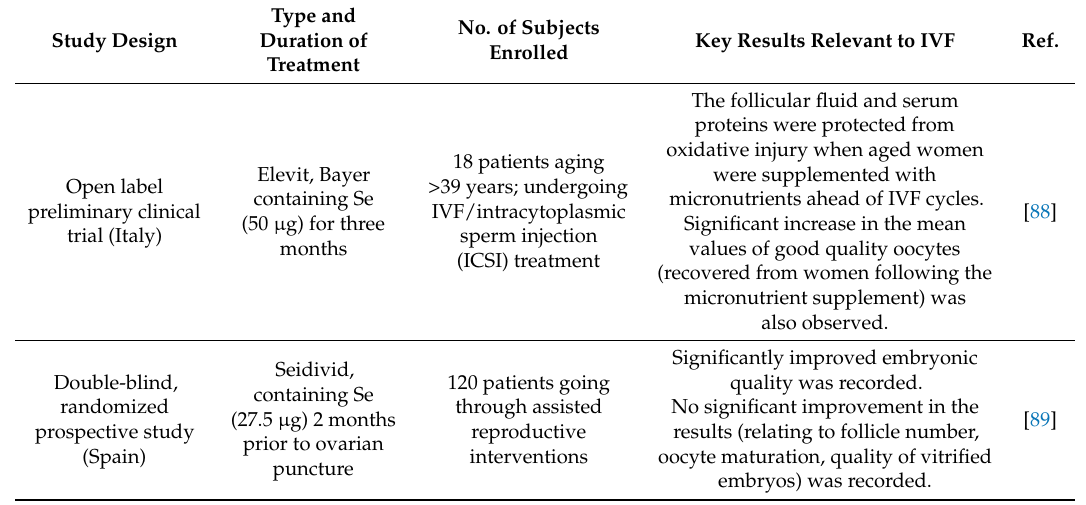
Table 3. Studies demonstrating the implication of selenium (as micronutrient supplement) in ameliorating the in vitro fertilization (IVF)